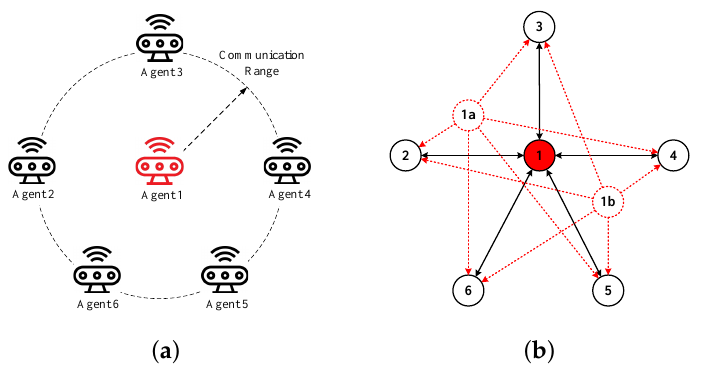
Figure 1. An example of the network under Sybil attacks. ( a ) Schematic diagram of network nodes’ locations; ( b ) Network communication topology